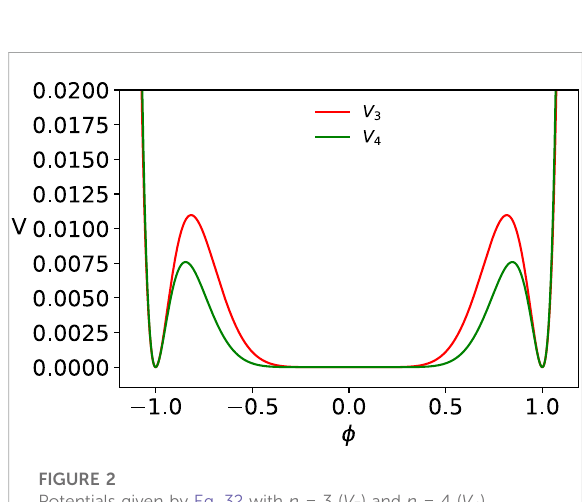
FIGURE 2 Potentials given by Eq. 32 with n = 3 ( V 3 ) and n = 4 ( V 4